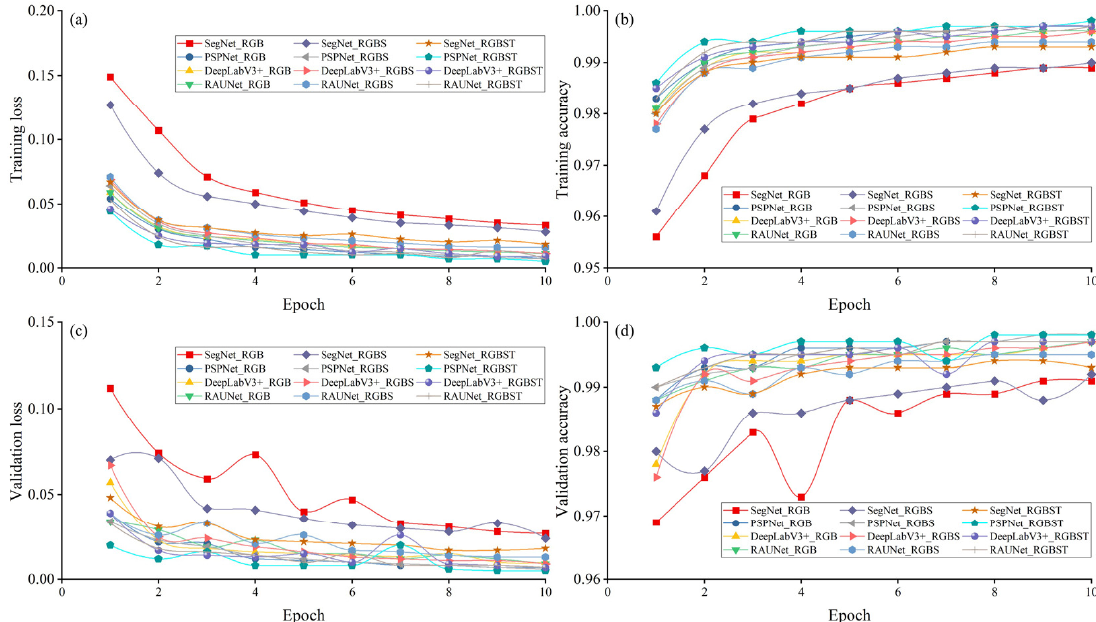
Figure A4. Training and validation curves for one-class classification of EC. ( a ) Training loss; ( b ) training accuracy; ( c ) validation loss; ( d ) validation accuracy.